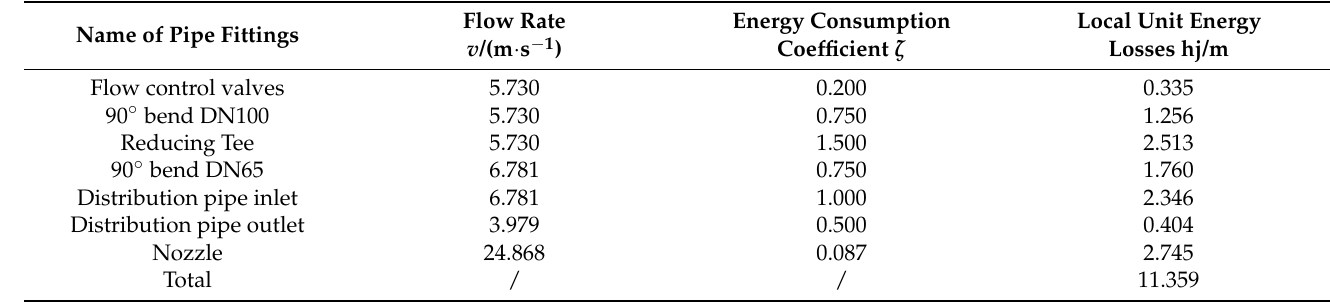
Table 2. Calculation table of local unit energy